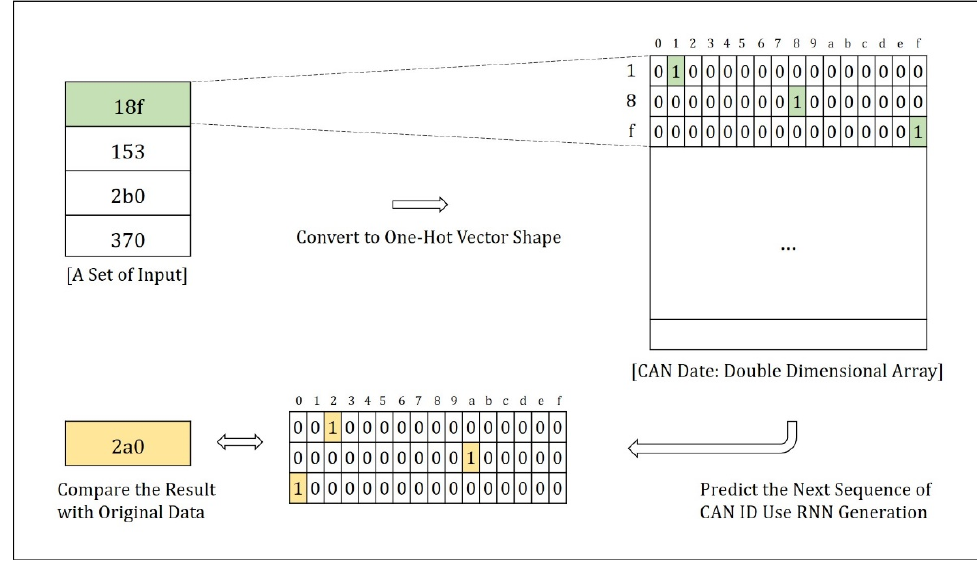
Figure 2. CAN ID prediction and one ‐ hot coding schematic.